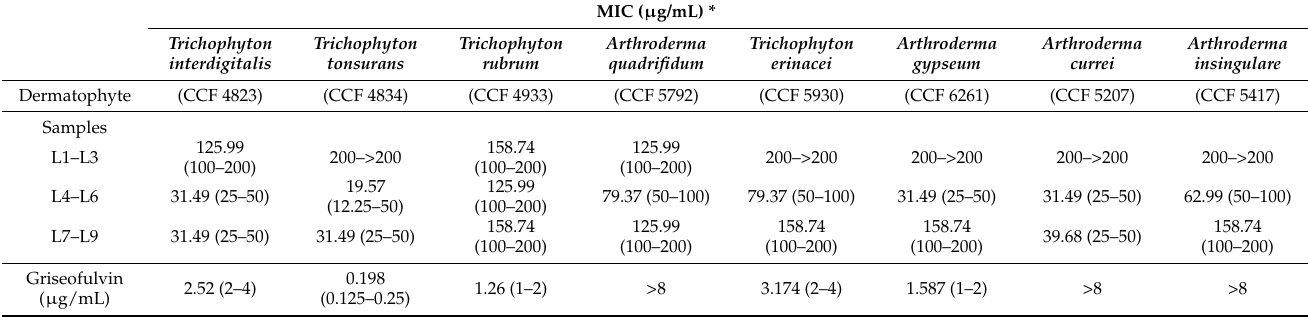
Table 8. Minimal inhibitory concentrations (MICs) of F. officinalis samples against dermatophyticx isolates. MIC ( µ g/mL)